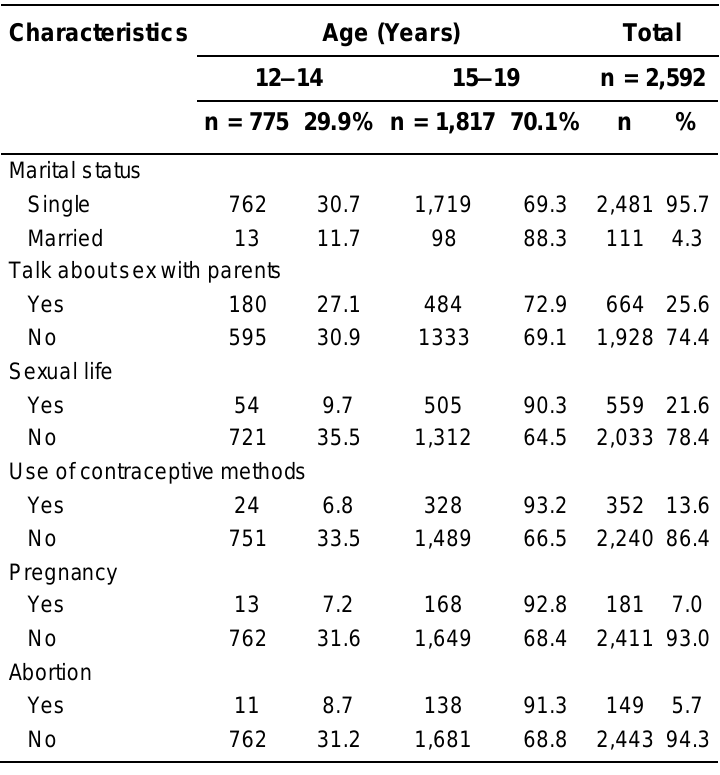
Characteristics of Adolescents Surveyed